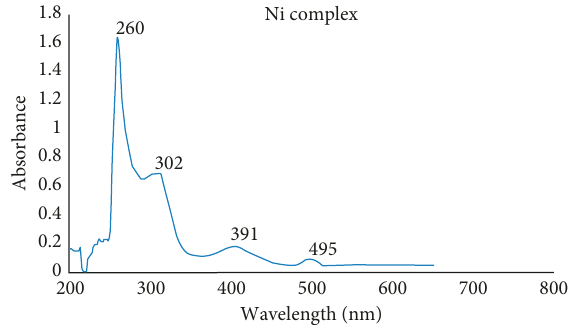
Figure 8: UV-visible spectrum of Ni(II) complex.